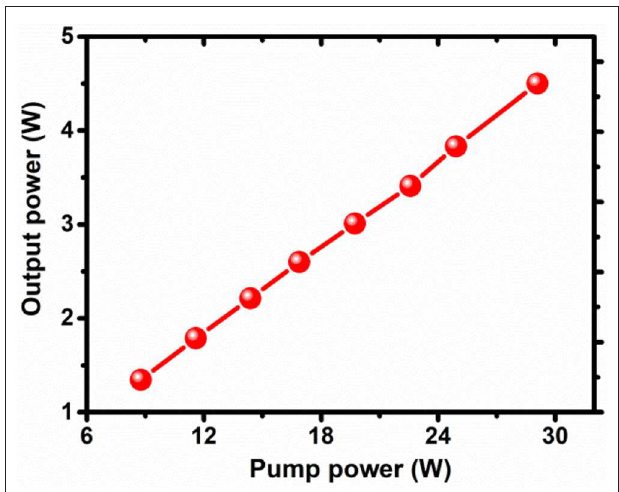
FIGURE 2 | Linearly increased mode-locked average power as a function of pump power.